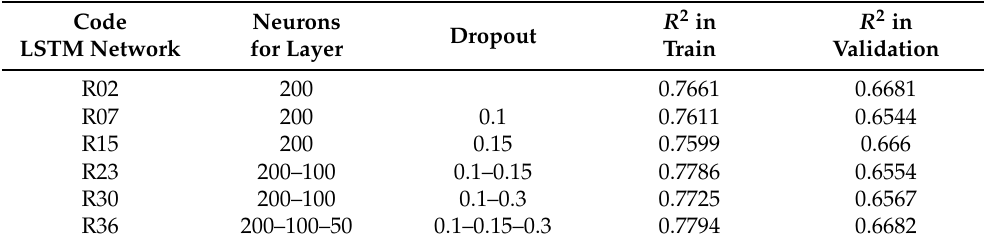
Table 5. Selection of six neural networks that present the highest values of R 2 in the dropout selection training group, number of neurons and LSTM